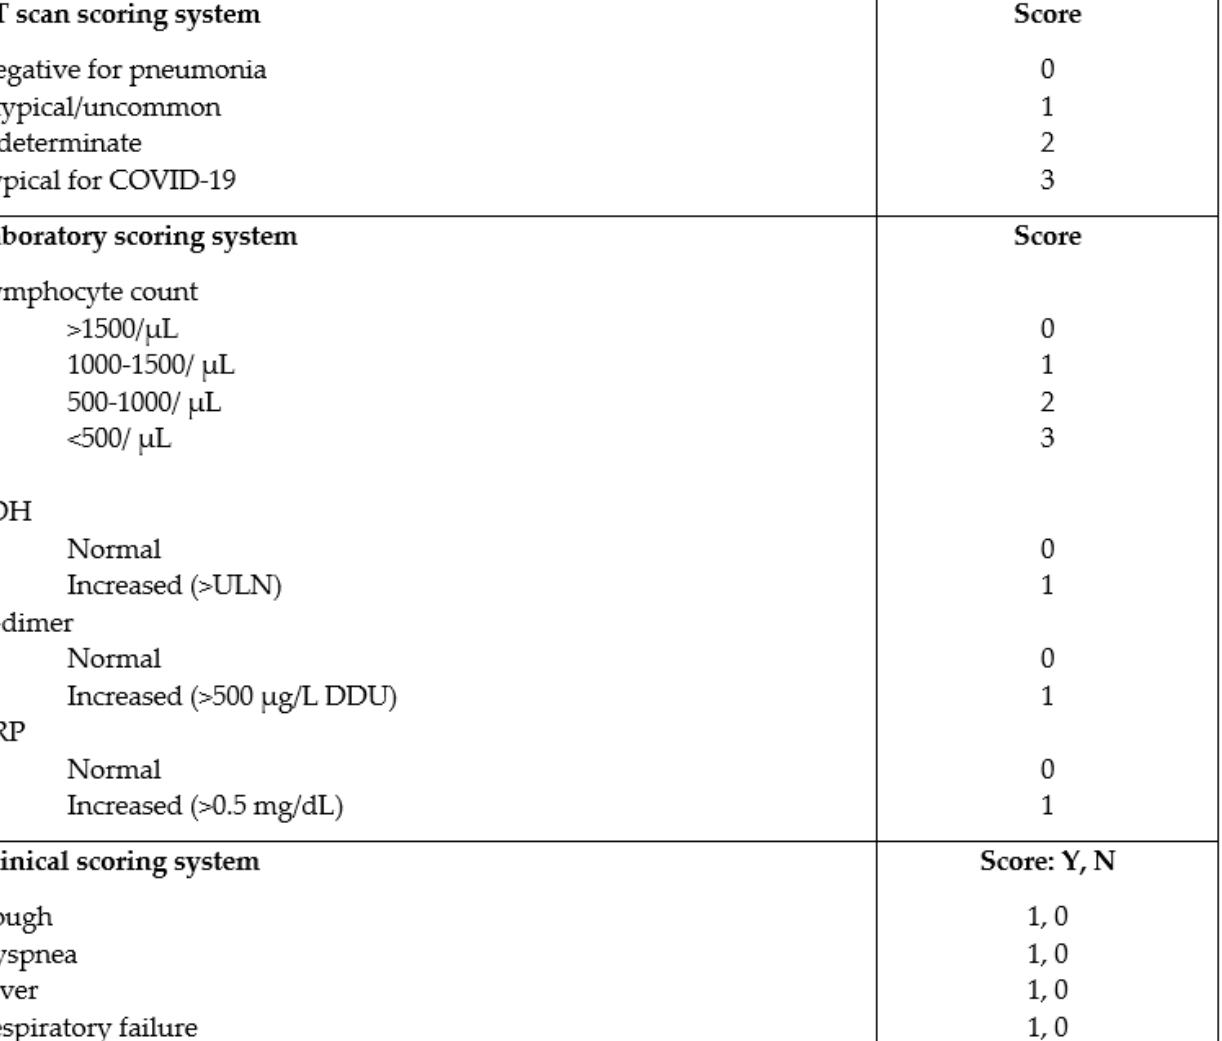
Figure 1. CT scan, laboratory and clinical scoring system. LDH=lactate dehydrogenase, CRP= C reactive protein, ULN= upper limit of normality, DDU = D-dimer unit, Y = yes, N = no.